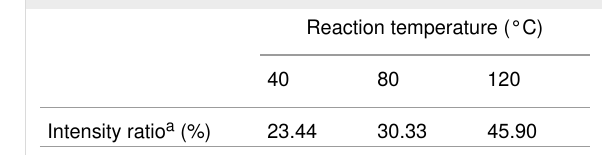
Table 1: Intensity ratios of ZIF-8 membranes synthesized at different reaction